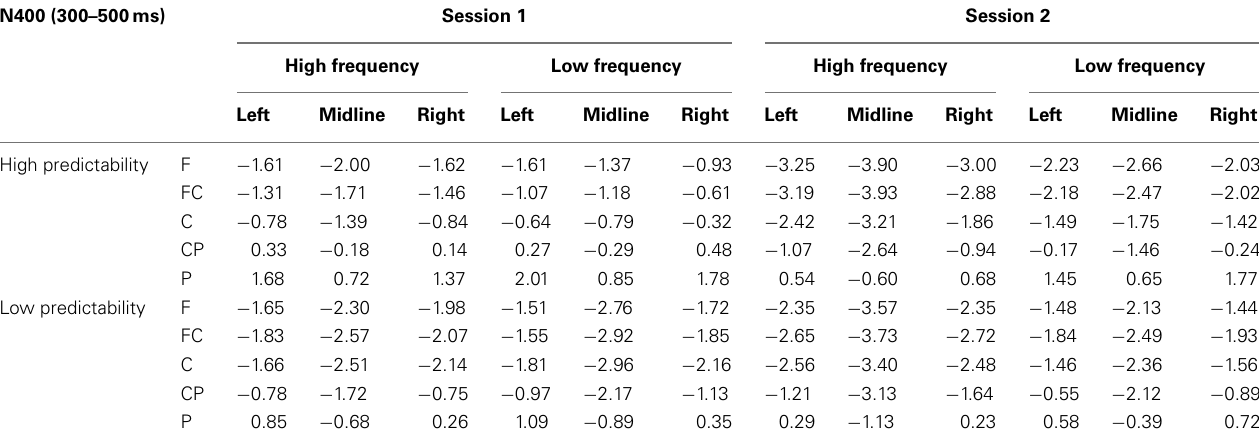
Table 4 | Mean amplitudes of N400 for each condition and each electrode of interest in each